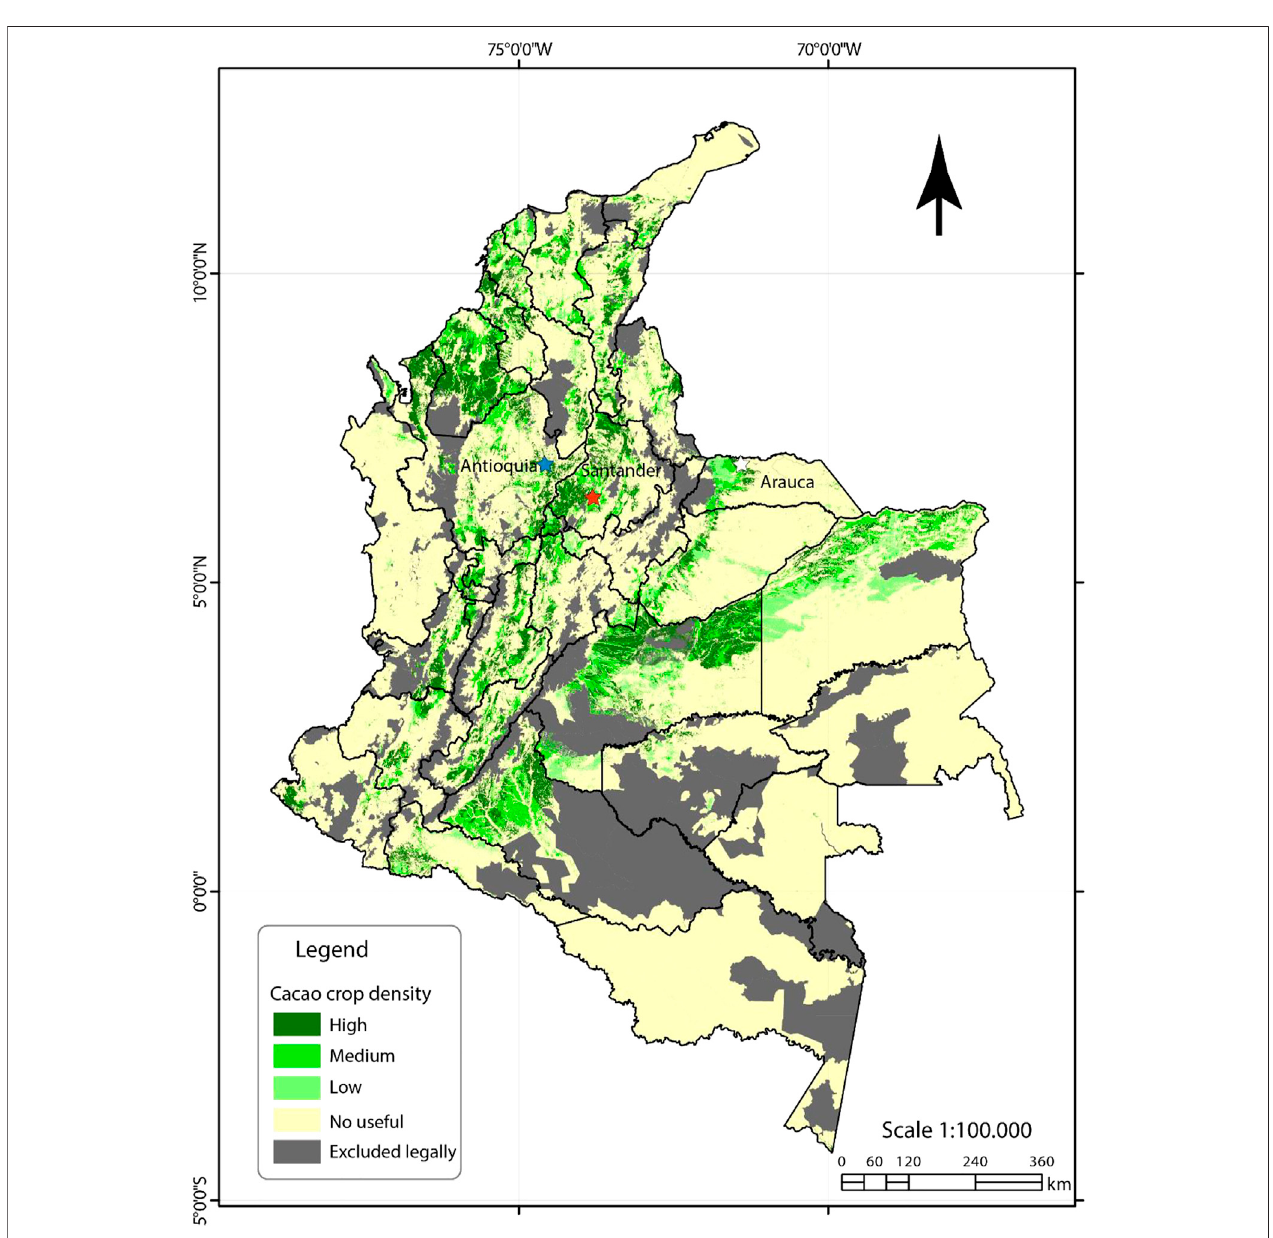
FIGURE 1 | Locations of the assessed composite soil samples. Each composite soil sample was compiled based on the sampling of 20 cacao-growing farms at each location. Therefore, a representativeness was assured for each location, selected for its traditional land uses for cacao production and high yielding of fi ne fl avour and aroma beans. In Antioquia district, the blue star included 20 samples from cacao-farms located in San Roque and Yolombó municipalities as part of the middle Magdalena mountain-system. The soil samples from the 20 assessed farms in Arauca are represented by a white star and are located in the municipality of Arauquita. In Santander, the 20 soil samples of farms assessed represented by a red star belongs to farms located in both San Vicente de Chucurí and El Carmen de Chucuri municipalities, as part of the Montaña Santandereana in the east cordilleras mountain-system. Adapted from UPRA ’ s map 2019.